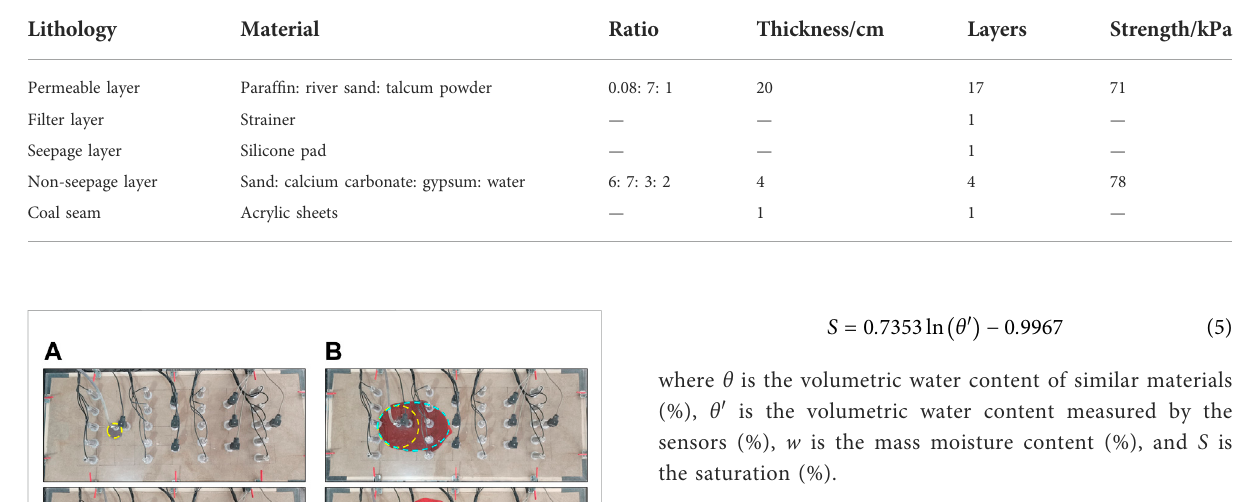
TABLE 2 Distribution of experimental lithology.